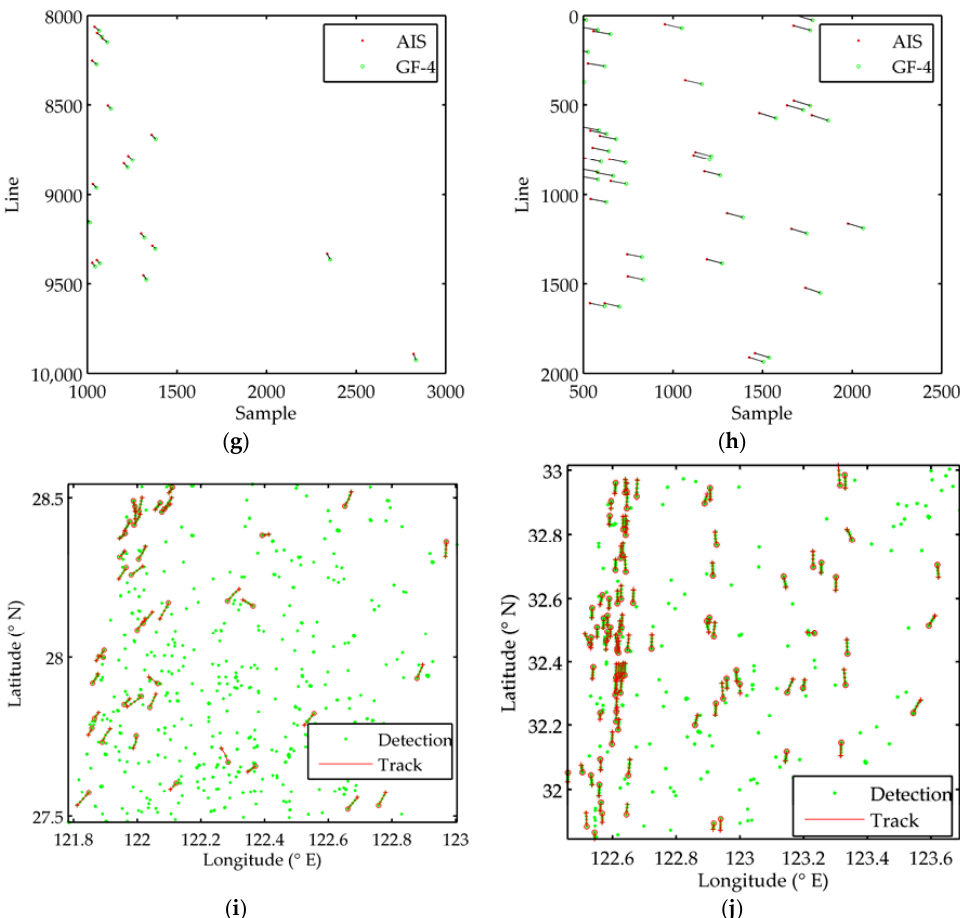
Figure 4. Detection and tracking results in two ROIs. ( a , b ) Intensity image in ROI 1 and ROI 2, respectively; ( c , d ) Results of ship detection in image coordinates in five frames; ( e , f ) GNN data association between AIS and GF-4detection in a single frame; ( g , h ) Point pairs after RANSAC processing; ( i , j ) Results of ship tracking in geographic coordinates using improved MHT. Table 2. Ship detection and tracking performance of the